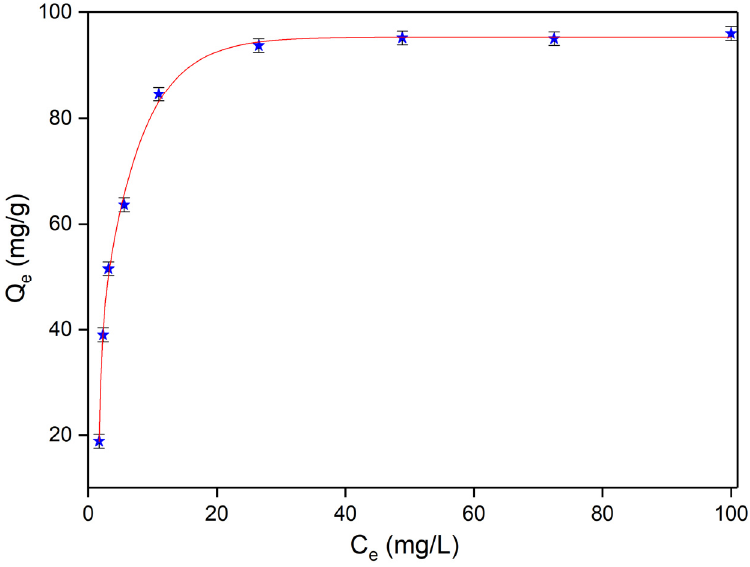
Figure 7. Graphical representation of the amount of Sr 2+ ions adsorbed at equilibrium by HAp nanoparticles.